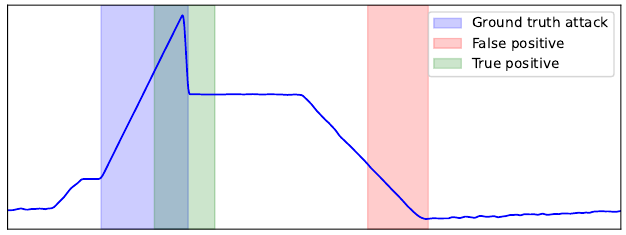
Figure 9. Example of true and false positive windows relative to the ground truth of an attack interval. An overlapping with the true attack interval (blue) yields a true positive window (green), while a non-overlapping window (red) yields a false positive